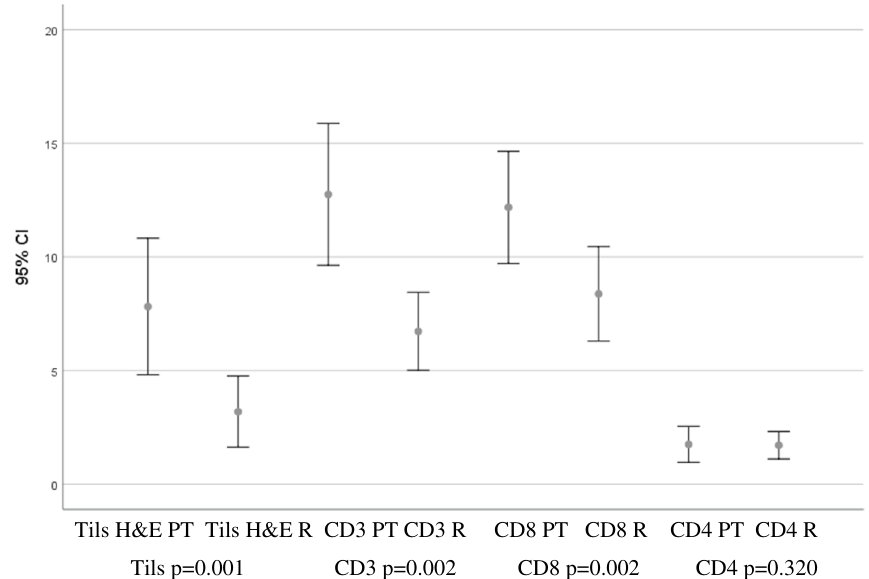
Fig. 3 Comparison of tumor infiltrating lymphocytes in primaries and recurrences, mean and 95 % confidence interval, p -values for significance of difference. Figure created with SPSS 22.0 for